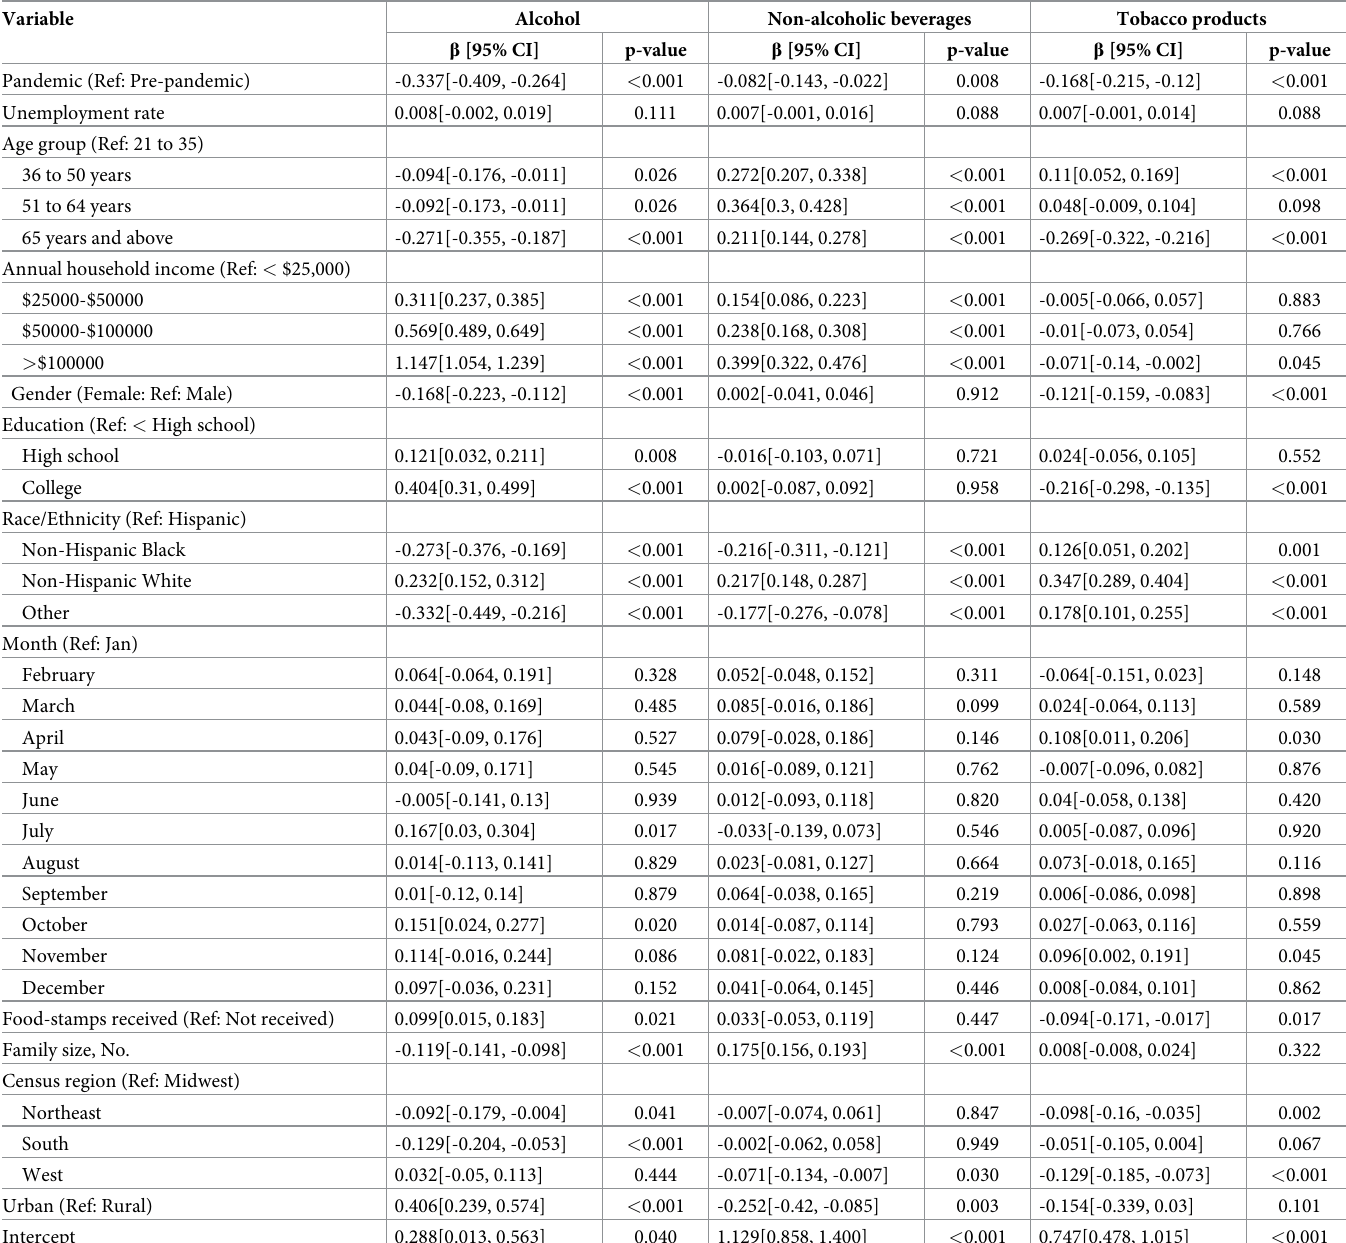
Table 2. Estimated regression coefficients from the base models for spending on alcohol, non-alcoholic beverages, and tobacco